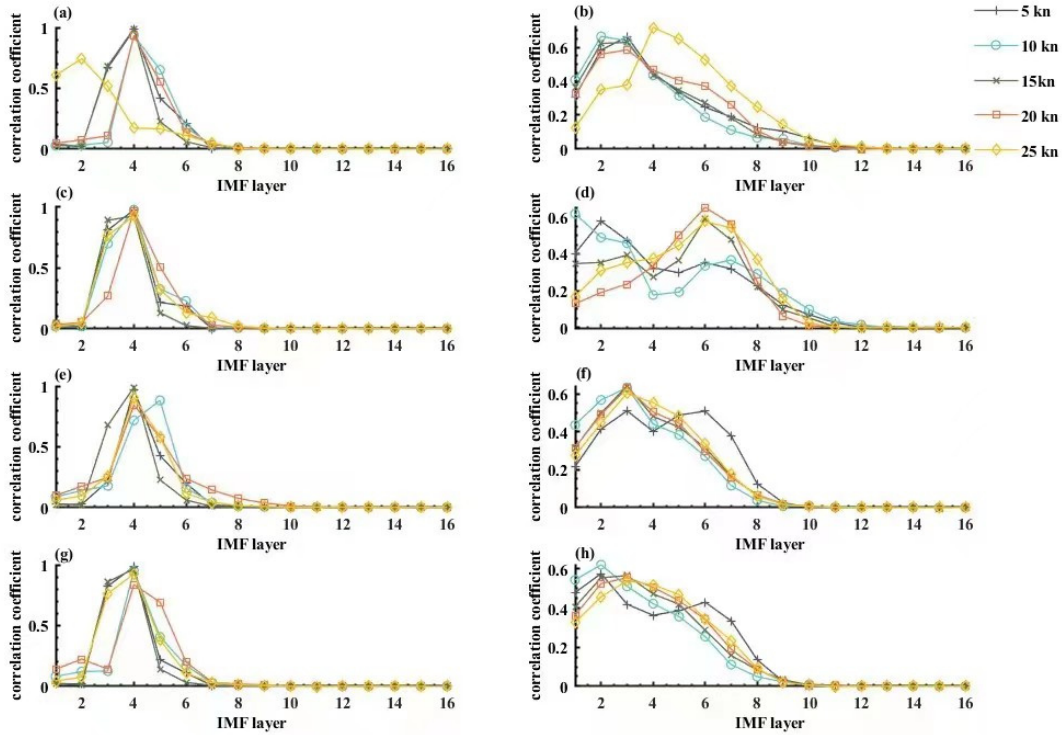
Figure 9. Correlation coefficients of IMF with and without targets as a function of decomposition layers.( a ) Correlation coefficients for Ex1 at the bow; ( b ) Correlation coefficients for Ex1 at the stern; ( c ) Correlation coefficients for Ey1 at the bow; ( d ) Correlation coefficients for Ey1 at the stern; ( e ) Correlation coefficients for Ex2 at the bow; ( f ) Correlation coefficients for Ex2 at the stern; ( g ) Correlation coefficients for Ey2 at the bow; ( h ) Correlation coefficients for Ey2 at the stern;